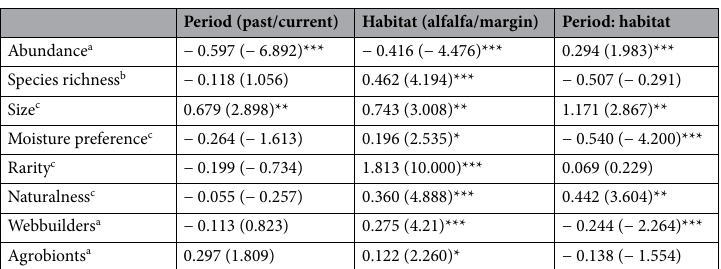
Table 2. Results of the LMM and GLMM models. Estimates (z/t values) are given. We included sampling year as random effect and sampling effort as offset in all models. Significance levels: *p < 0.05; **p < 0.01; ***p < 0.001. a Model fitted with negative binomial error term (GLMM). b Model fitted with Poisson error term (GLMM). c Model fitted with Gaussian error term